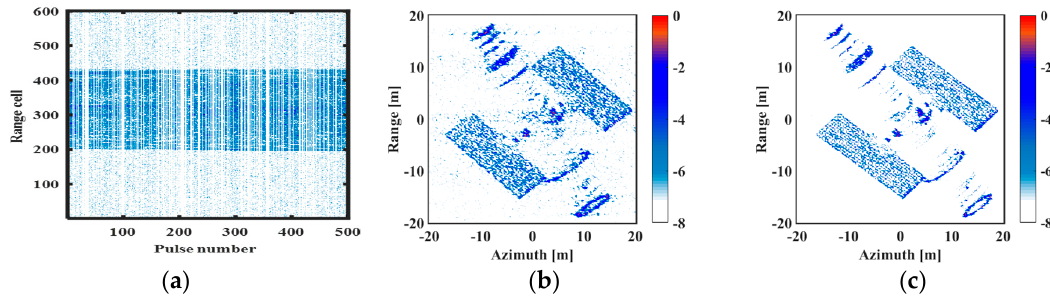
Figure 13. Range profiles and imaging results with RMS of 300 pulses: ( a ) Range profiles; ( b ) Imaging result of algorithm in [23]; ( c ) Imaging result of the proposed algorithm.